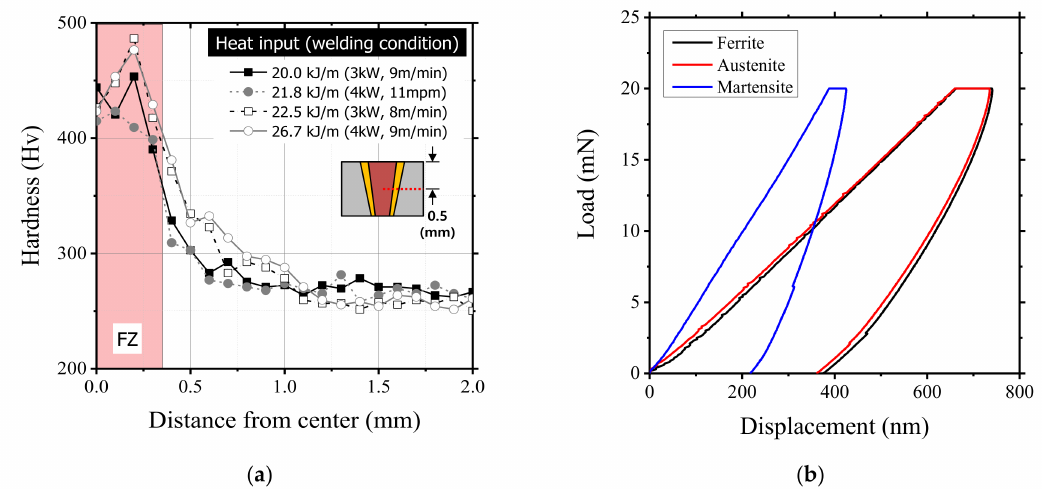
Figure 11. ( a ) Hardness profile of the welded specimen of the various heat input conditions at the middle of the thickness. Specimen was prepared using a laser power of 4 kW with a welding speed of 9 to 11 m/min; ( b ) load-displacement curves of all constituent